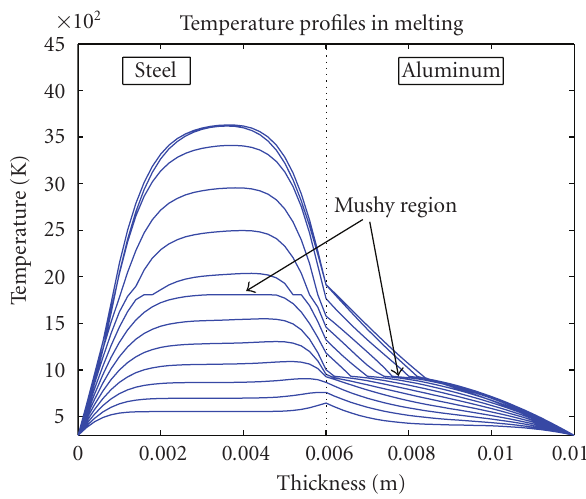
Figure 4.10. Example 4: spatial and temporal variation of temperature. The dotted line is the interface between the plates. The curves represent equal time